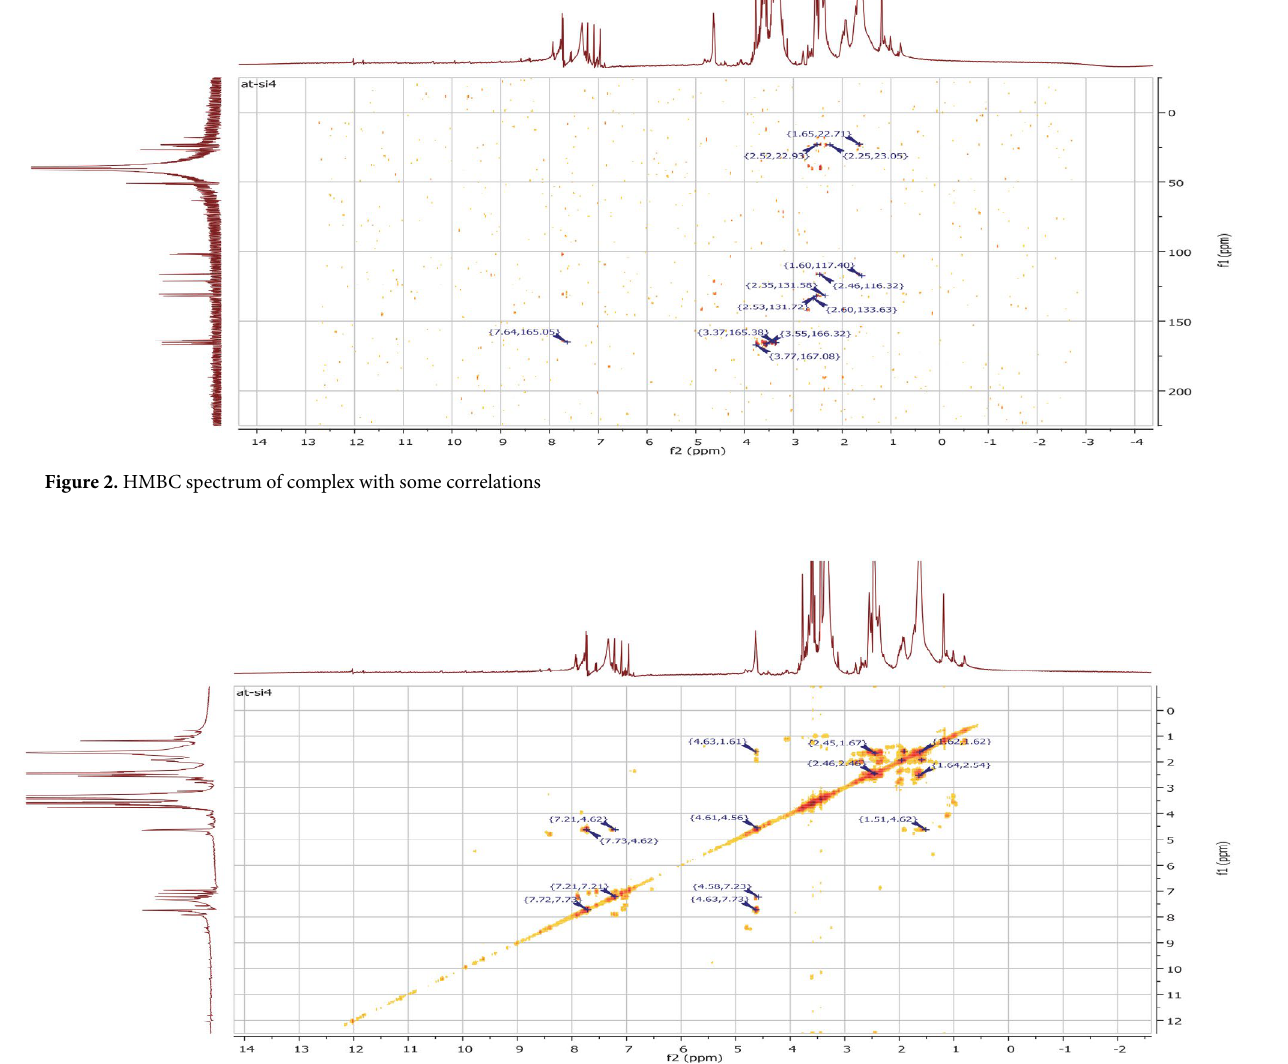
Figure 3. COSY spectrum of complex with some